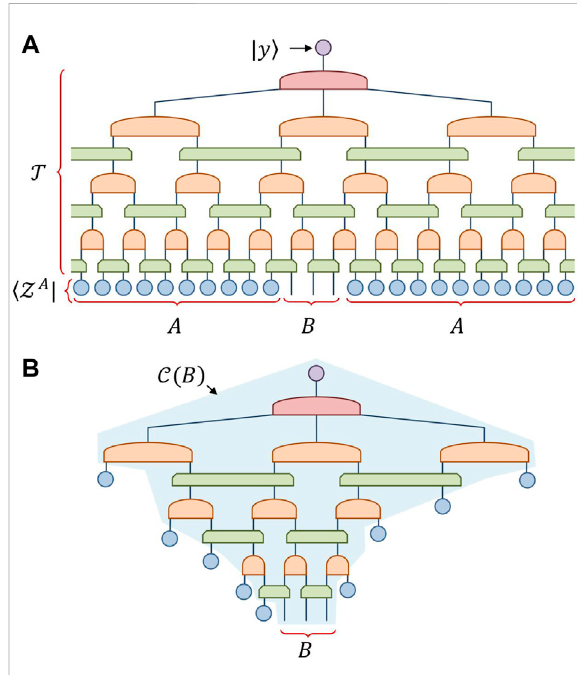
FIGURE 5 (A) The network T with fi xed output label | y 〉 is applied to a number state 〈 Z A | de fi ned only on a sub-region A of the initial lattice, with the state on the complimentary region B left open. (B) The input number-state 〈 Z A | is lifted through T as much as is possible by using the number-state mapping properties depicted in Figure 1. The (con fi guration) causal cone C ( B ) associated to region B describes the remaining set of tensors C ∈ T after this lifting; this is equivalently the set of tensors whose output states can be affected by the choice of input state on region B